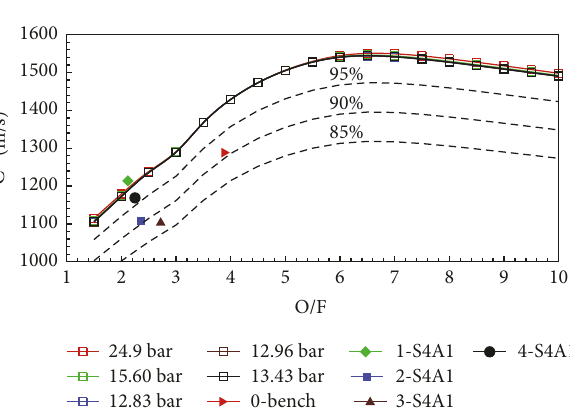
Figure 12: Effect of swirl flow on characteristics velocity.